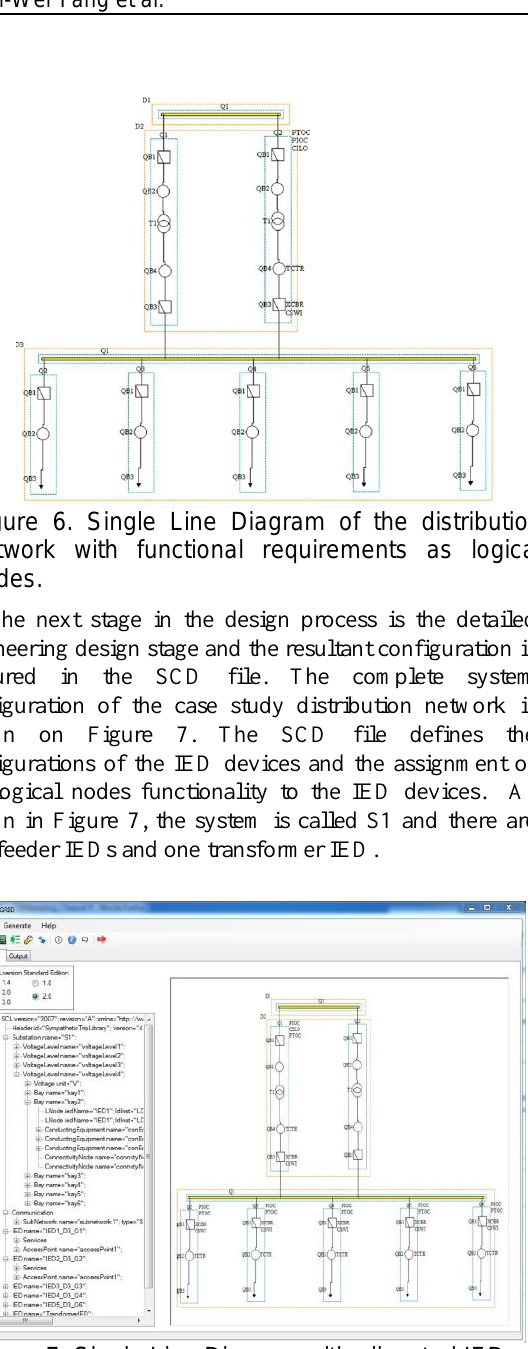
Figure 7. Single Line Diagram with allocated IEDs and system configuration.